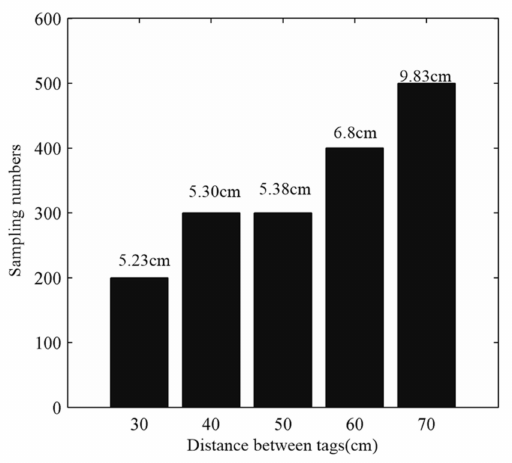
Figure 15. Effects of tag density and sampling number on the average positioning